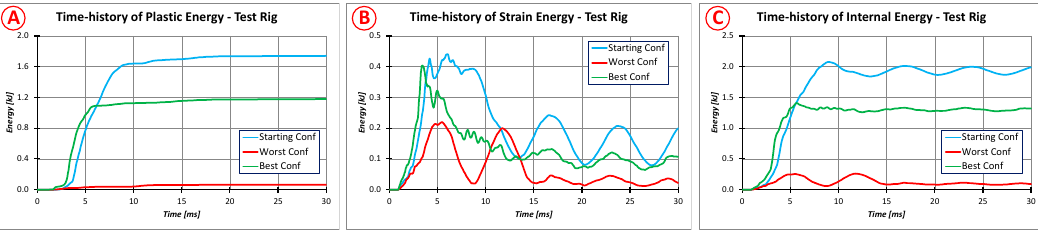
Figure 13. Energy balance for the test rig. ( A ) Plastic energy; ( B ) strain energy; ( C ) internal energy.